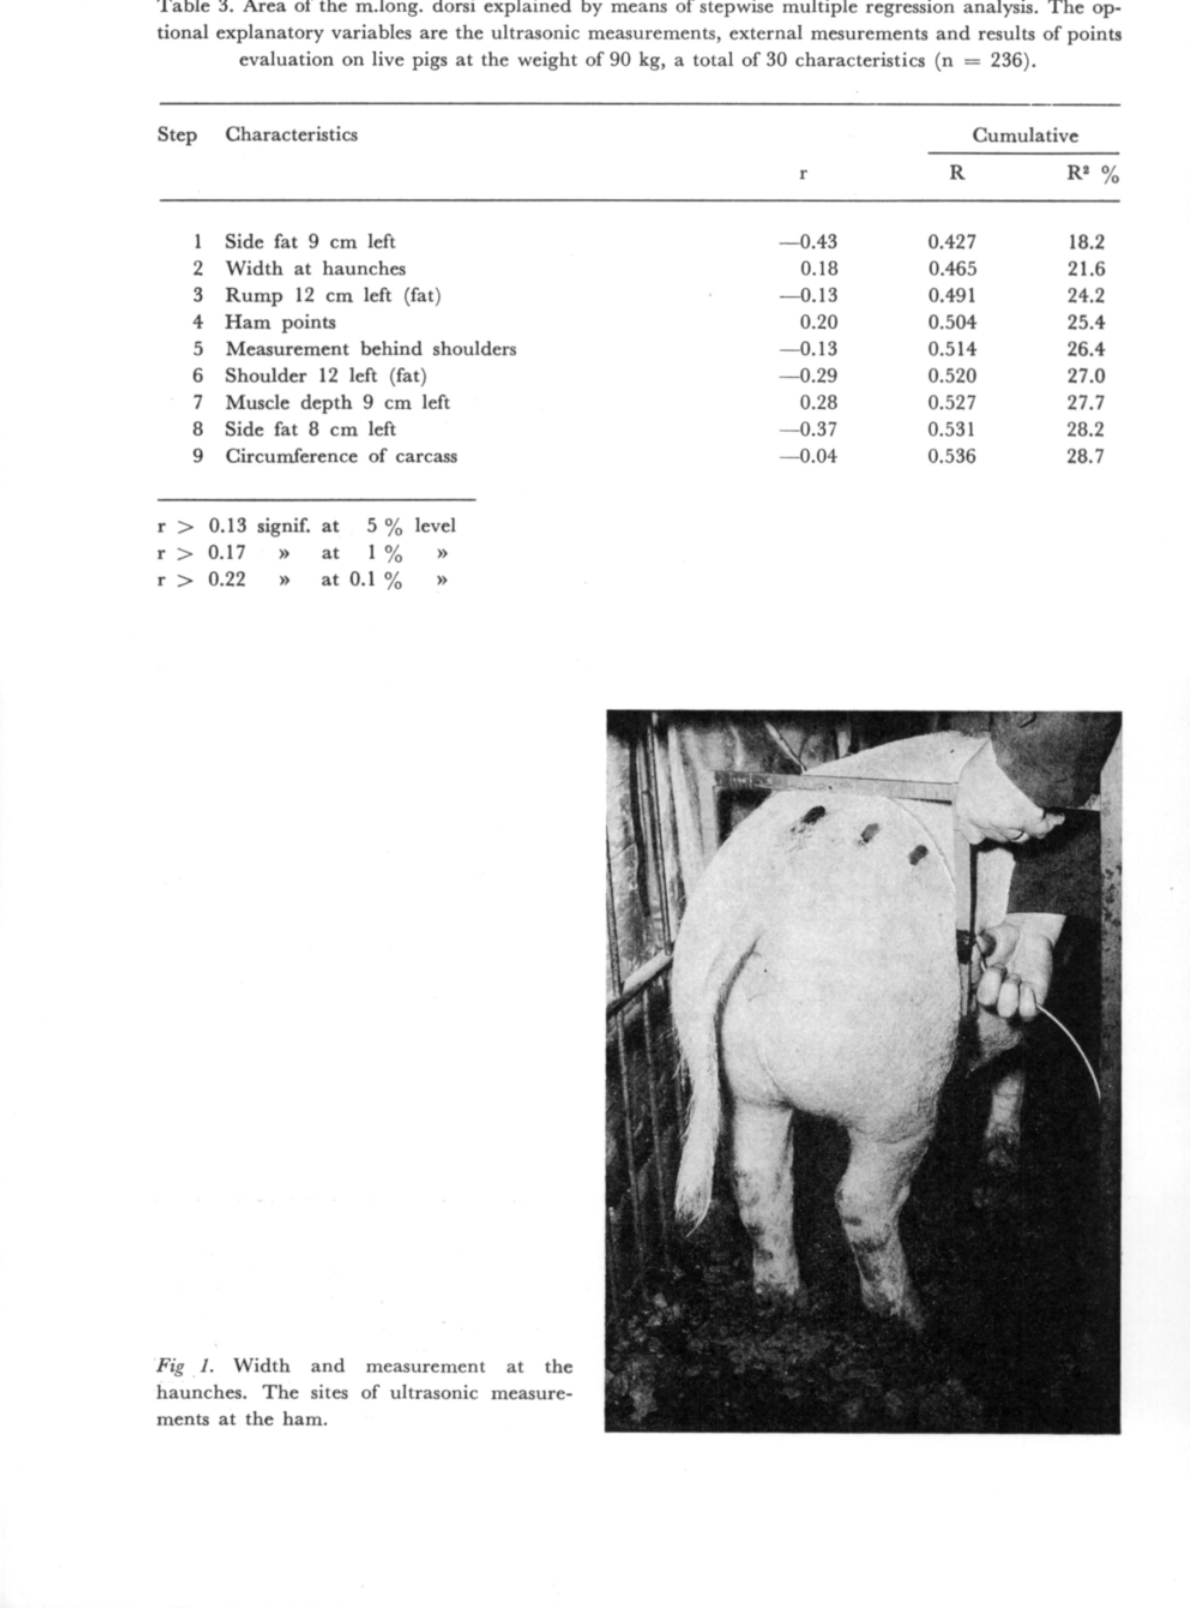
Table 3. Area of the m.long. dorsi explained by means of stepwise multiple regression analysis. The op- tional explanatory variables are the ultrasonic measurements, external mesurements and results of points evaluation on live pigs at the weight of 90 kg, a total of 30 characteristics (n